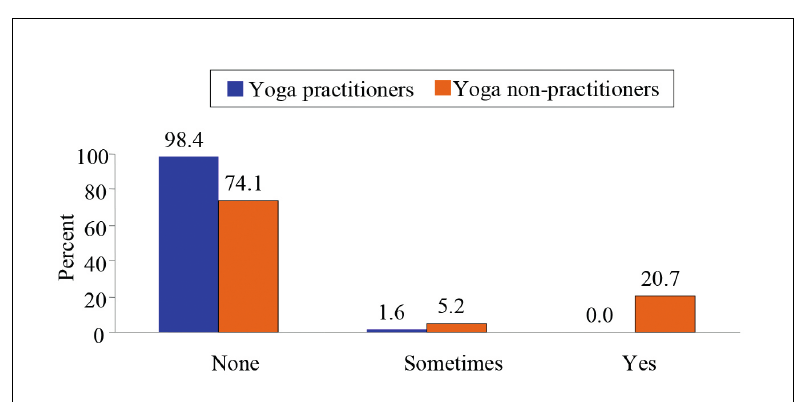
Note. x ² = 16, df = 2, p < .05.